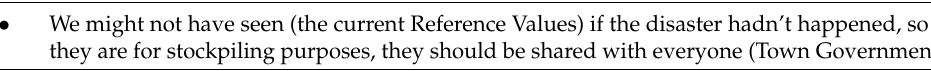
Table 5. Is there a need for Reference Values for stockpile planning that can be used during normal times?